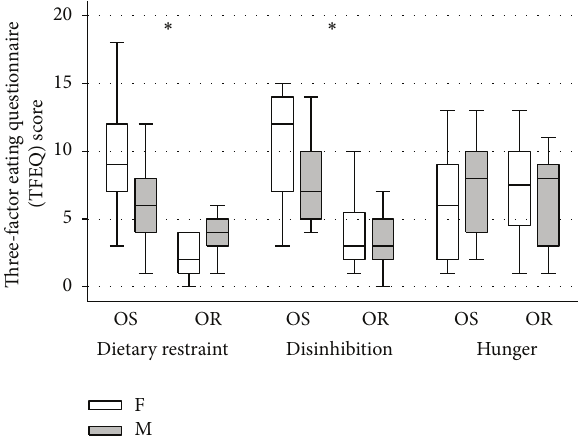
Figure 1: Three-factor eating questionnaire (TFEQ) scores for obesity resistant (OR) females (F) and males (M) versus obesity susceptible (OS) females (F) and males (M). Values are medians in 25th and 75th interquartile range. ∗ = obesity resistant < obesity susceptible 𝑃 < 0.001